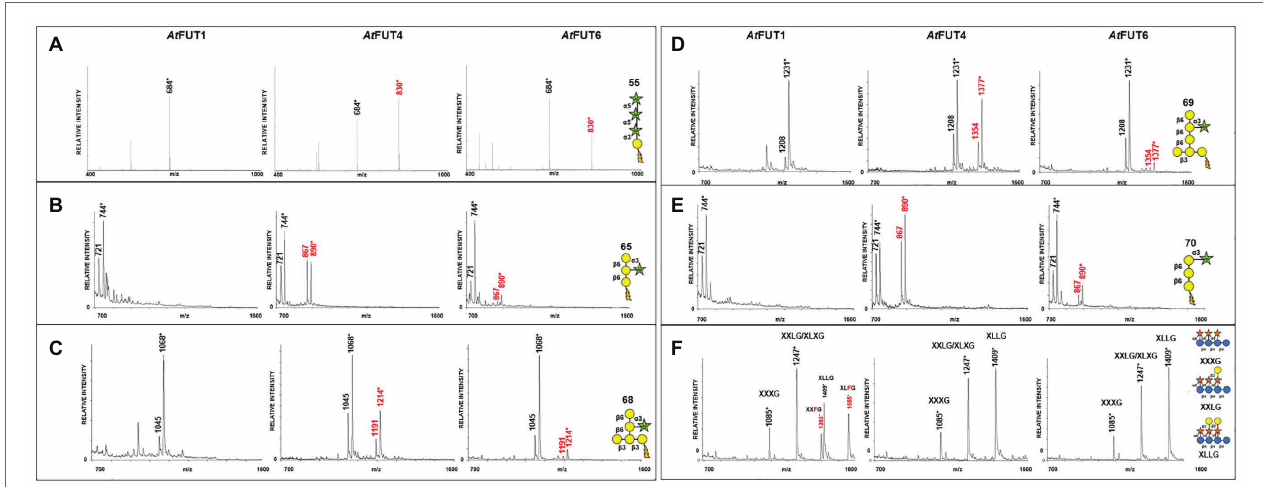
FIGURE 3 | Matrix-assisted laser desorption/ionization-time of flight mass spectrometry (MALDI-TOF MS) data for GFP- At FUT1, GFP- At FUT4, and GFP- At FUT6 reacted with different acceptor substrates. (A) Acceptor 55, (B) Acceptor 65, (C) Acceptor 68, (D) Acceptor 69, (E) Acceptor 70, and (F) XG acceptors. Transfer of Fuc increases the mass of the acceptor by 146 Da, as indicated by annotating (M + H + ) ions, (*) denotes (M + Na + )